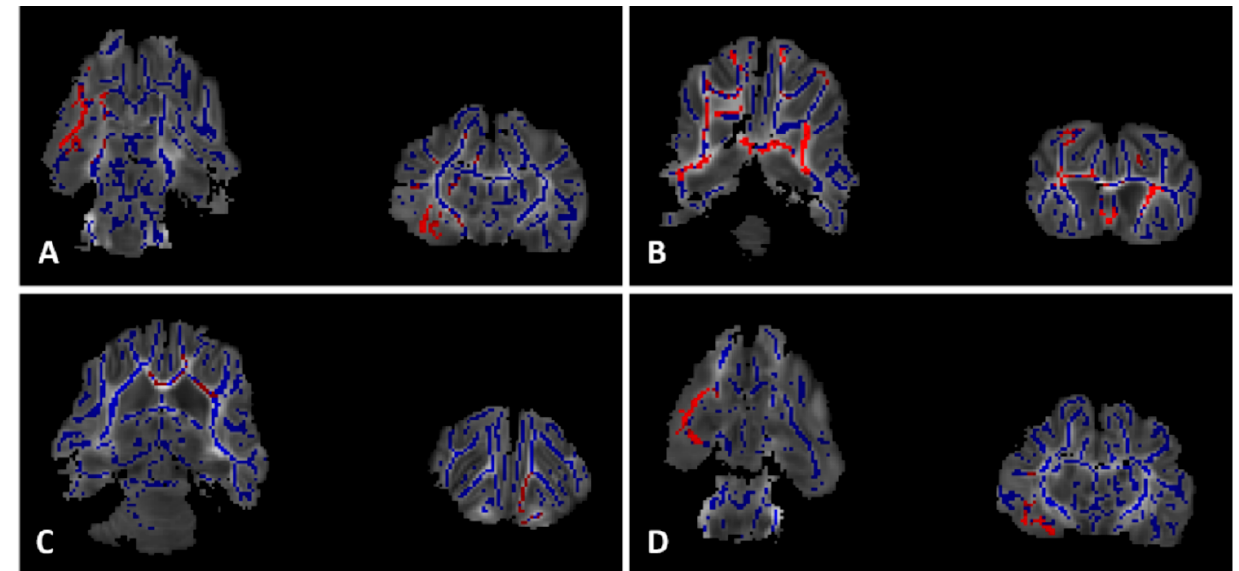
Figure 4. Diffusion Tensor Imaging. Comparison of FA values throughout the white matter (blue). Light red indicates p < 0.15 and dark red indicates p < 0.05 after threshold-free cluster enhancement (TFCE) adjustment for multiple comparisons. ( A ) Contol FA values greater than Veh FA values in the dorsal striatum and substantia innominata. ( B ) TH FA values greater than Veh FA values throughout cerebral white matter. ( C ) Epo FA values greater than Veh FA values in the anterior cerebral white matter and interior capsule. ( D ) Control FA values greater than Epo FA values in the peri-hippocampal cerebral white matter tracts.